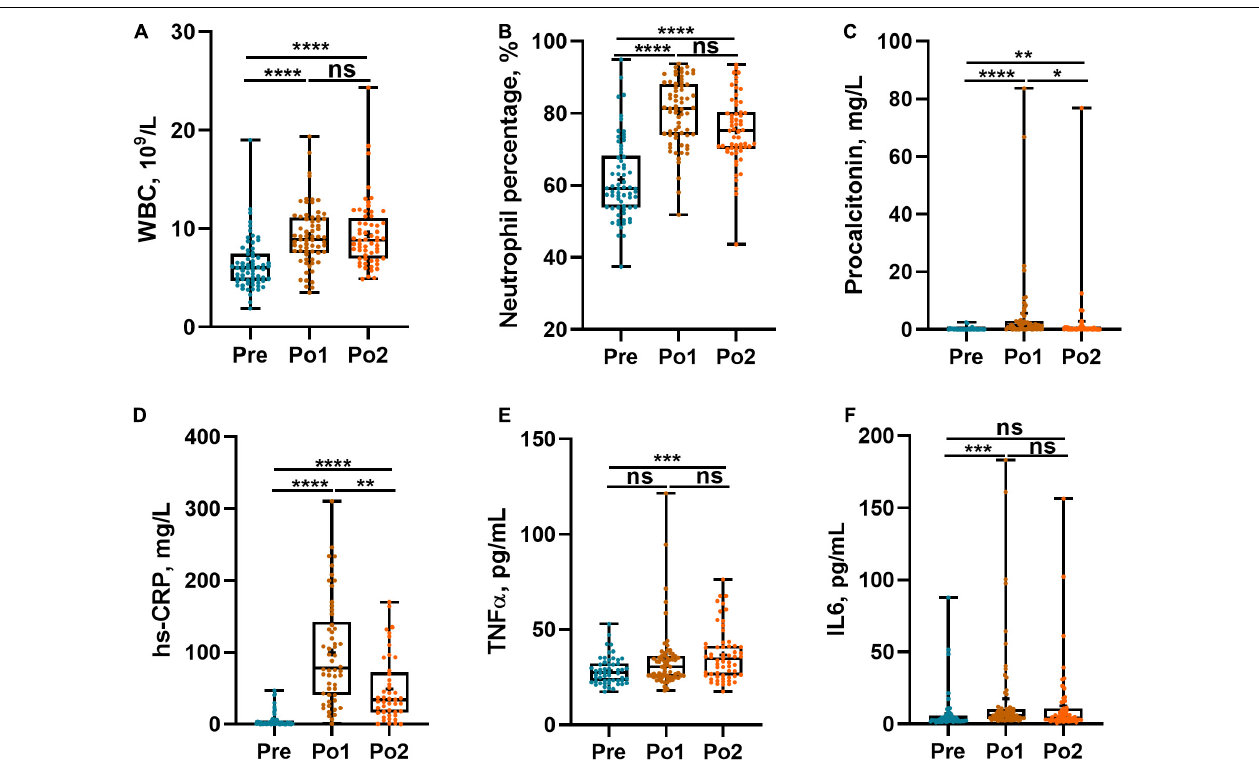
FIGURE 1 | Perioperative systemic infection biomarkers of cohorts. WBC (A) , percentage of neutrophil count (B) , PCT (C) , hs-CRP (D) , TNF- α (E) , and IL-6 (F) were assessed across time series. Statistical assessment was carried out with one-way analysis of variance or Kruskal–Wallis test for parametric or non-parametric data followed by post hoc test using Dunn’s multiple comparison test. P < 0.05 indicates statistical significance (* P < 0.05, ** P < 0.01, *** P < 0.001, and **** P < 0.0001), and ns means P > 0.05. Results are expressed as median and